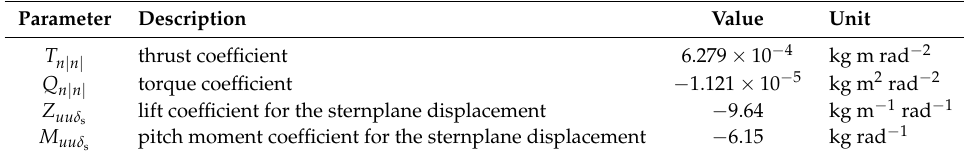
Table A3. Actuation parameters taken from [24].